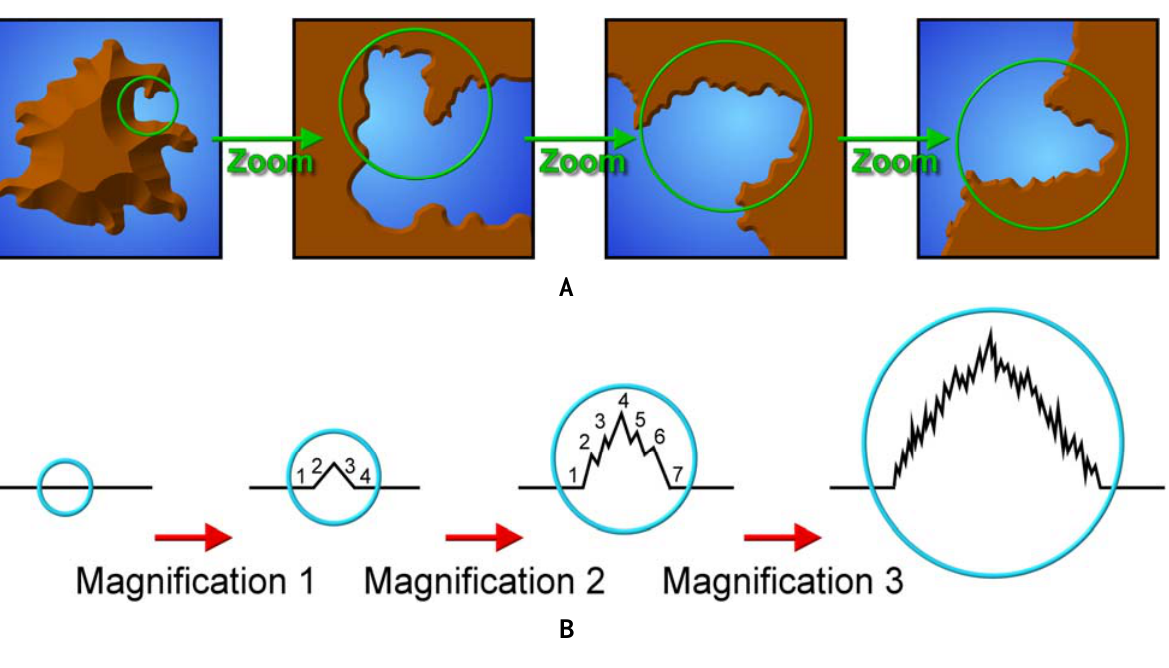
Figure 10. A. Schematic of a coastline demonstrating the concept of a natural fractal’s self-similarity. Note the similarity of contours at various levels of magnification. B. Schematic of a dimensional fractal. Notice the increase in Df with increasing levels of magnification (shown inside the circled